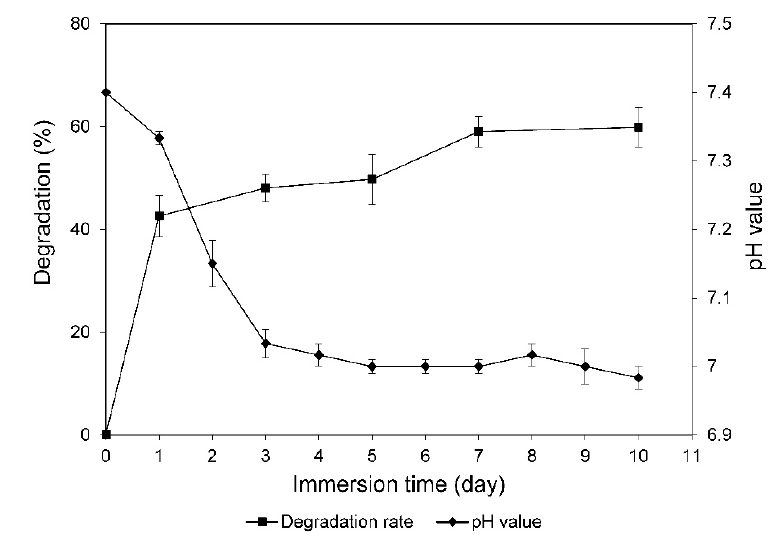
Figure 7. Degradation rate and pH value of CS cements after 0, 1, 3, 5, 7, and 10 days immersed in Tris–SBF-27 solution.